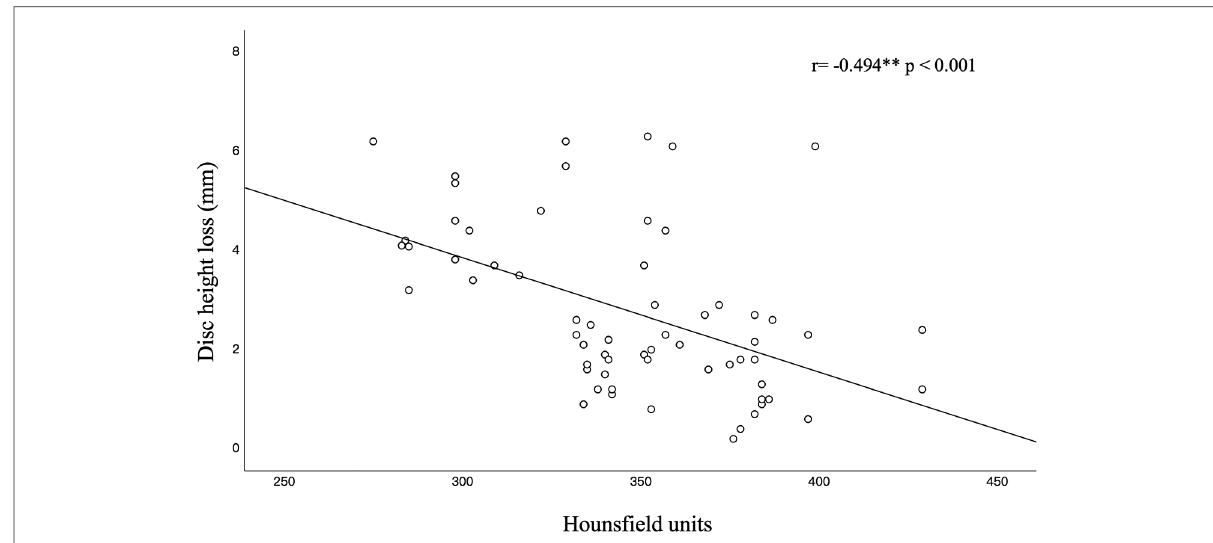
FIGURE 3 Linear correlation (black line) between HU and the TMC subsidence correlation coef fi cient ( r ) at the overall cervical vertebrae. Signi fi cant correlation coef fi cients are indicated by